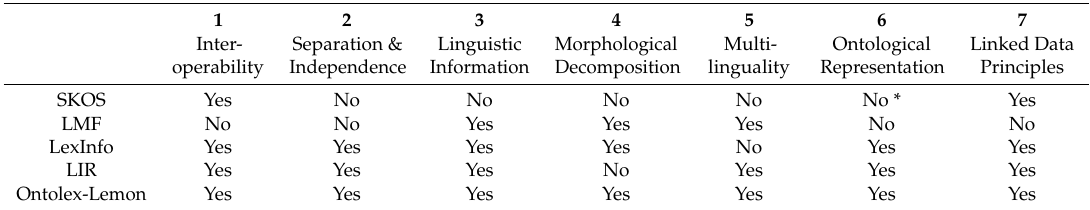
Table 1. Features of the models which correspond to the modelling requirements, derived from Cimiano et al. [35] (p. 33).